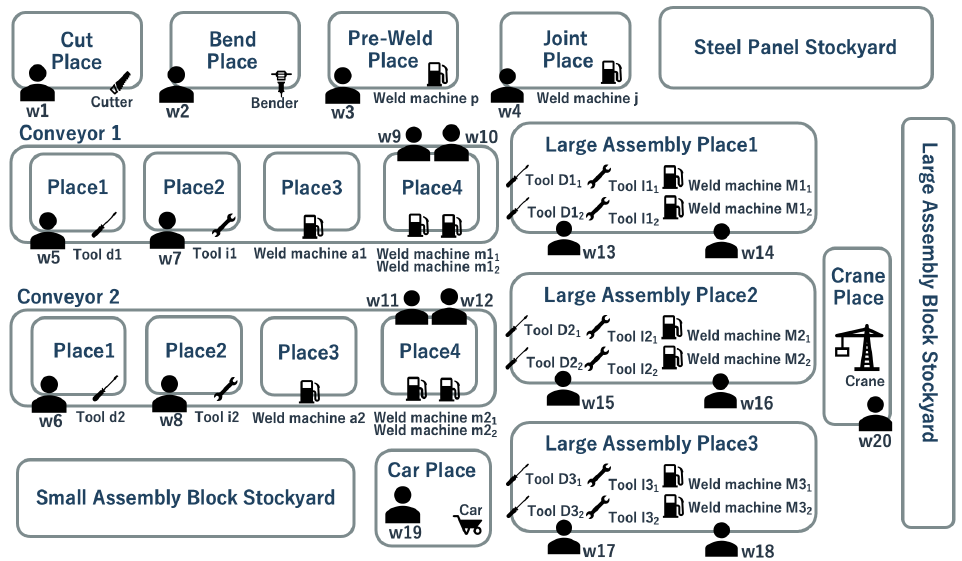
Figure 9. Layout of the Virtual